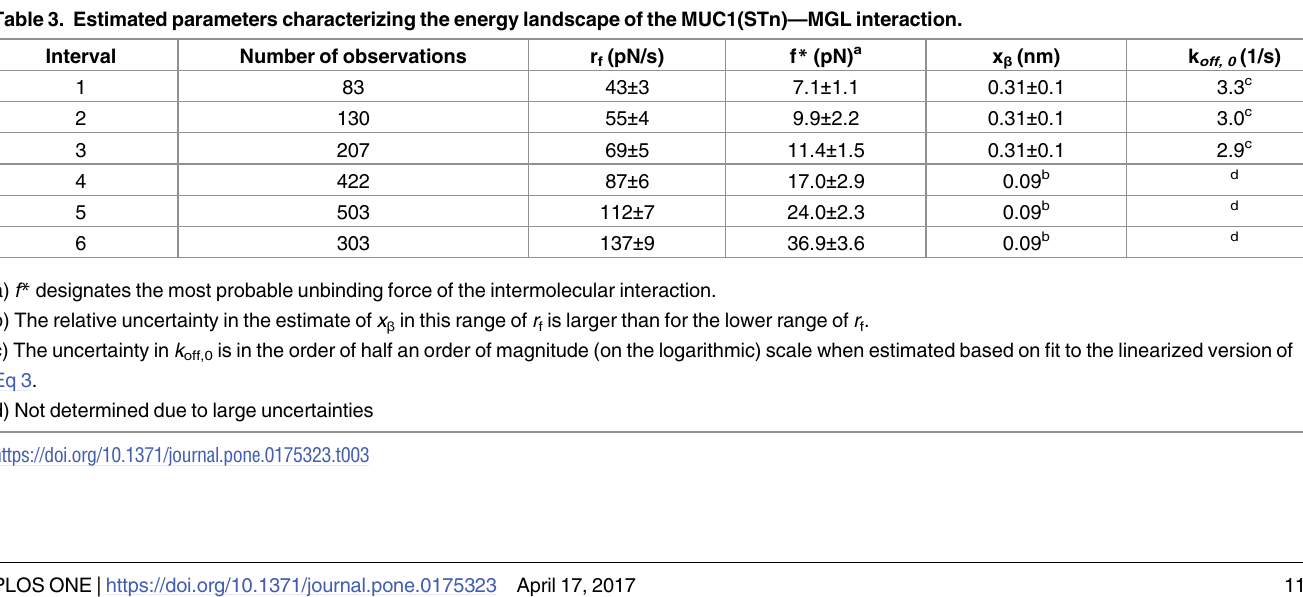
ture of intermolecular bonds were observed upon bead separation. Based on the obtained observed for these interactions are presented in Fig 7.